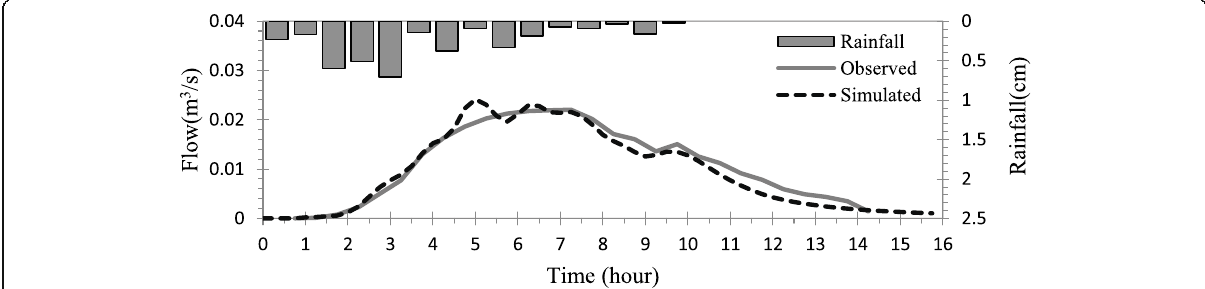
Fig. 4 Comparison of simulated and observed hydrographs derived from calibration, run for the rainfall event of 08-02-2011